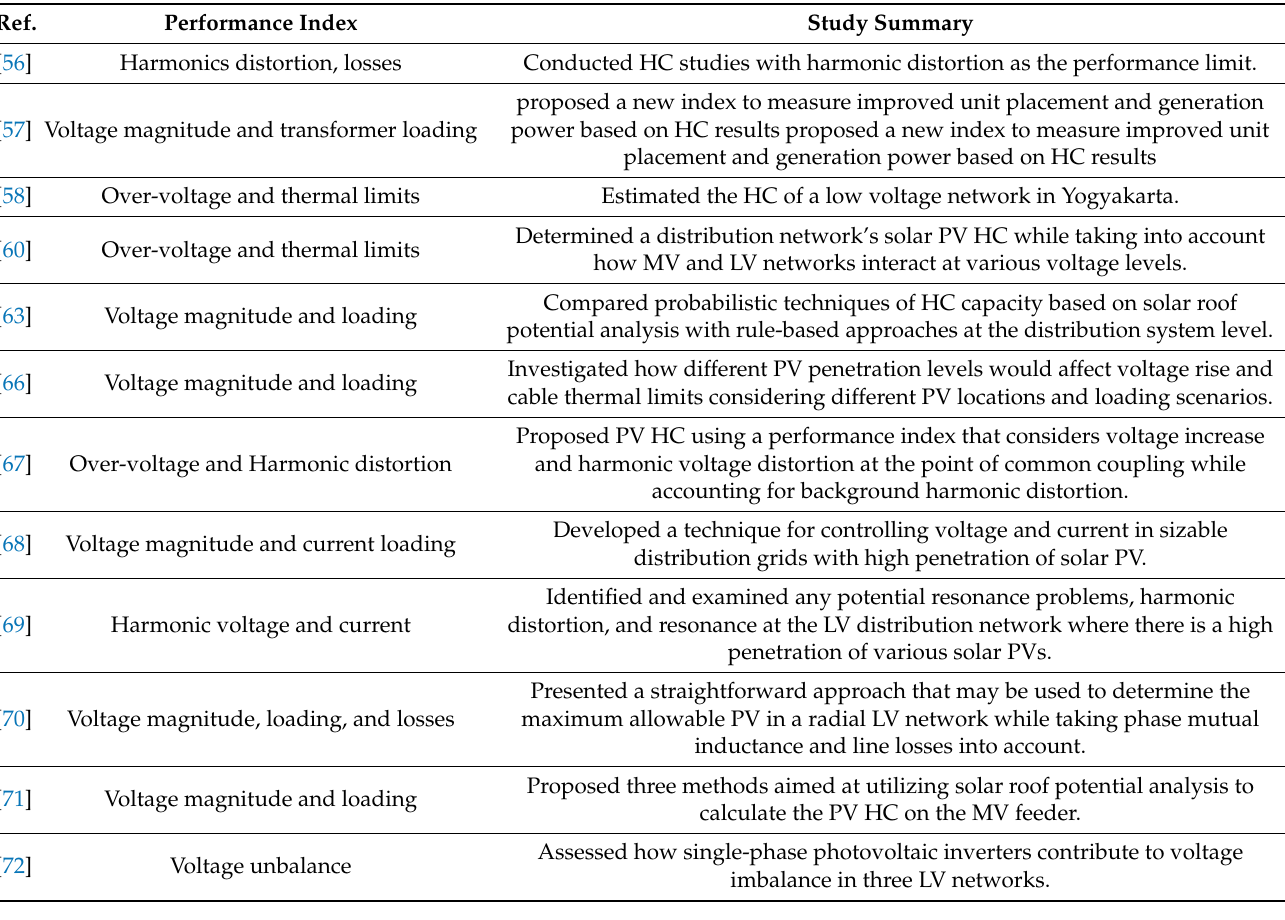
Table 2. Summary of studies that adopt the deterministic method for PV Hosting capacity determination.